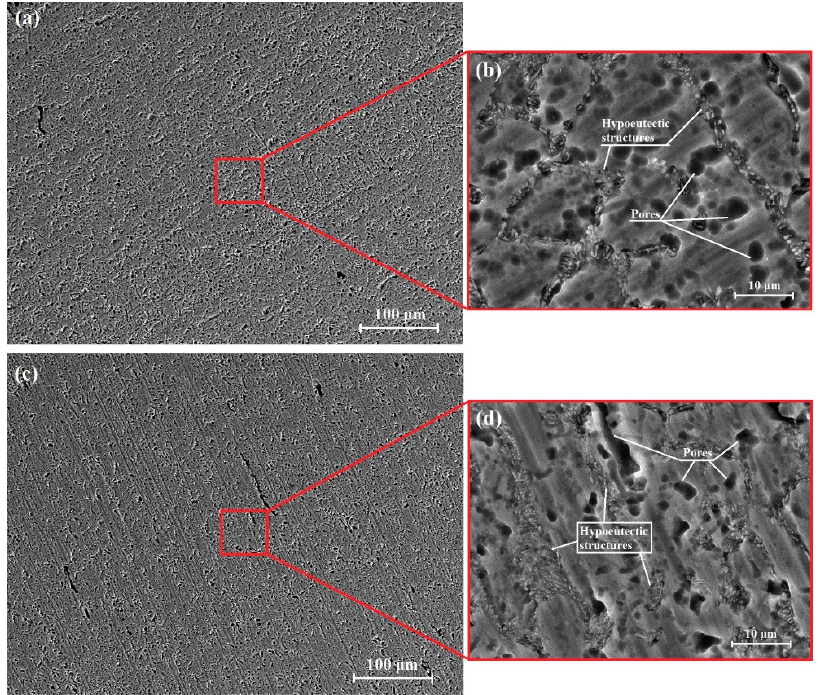
Figure 5. Cross sectional SEM micrographs of the specimen built at a welding speed of 13.3 mm/s: larger scale micrographs of samples T ( a ) and M2 ( c ) taken in the BSE mode, and closer studied areas of both samples ( b , d ) taken in the SE mode.